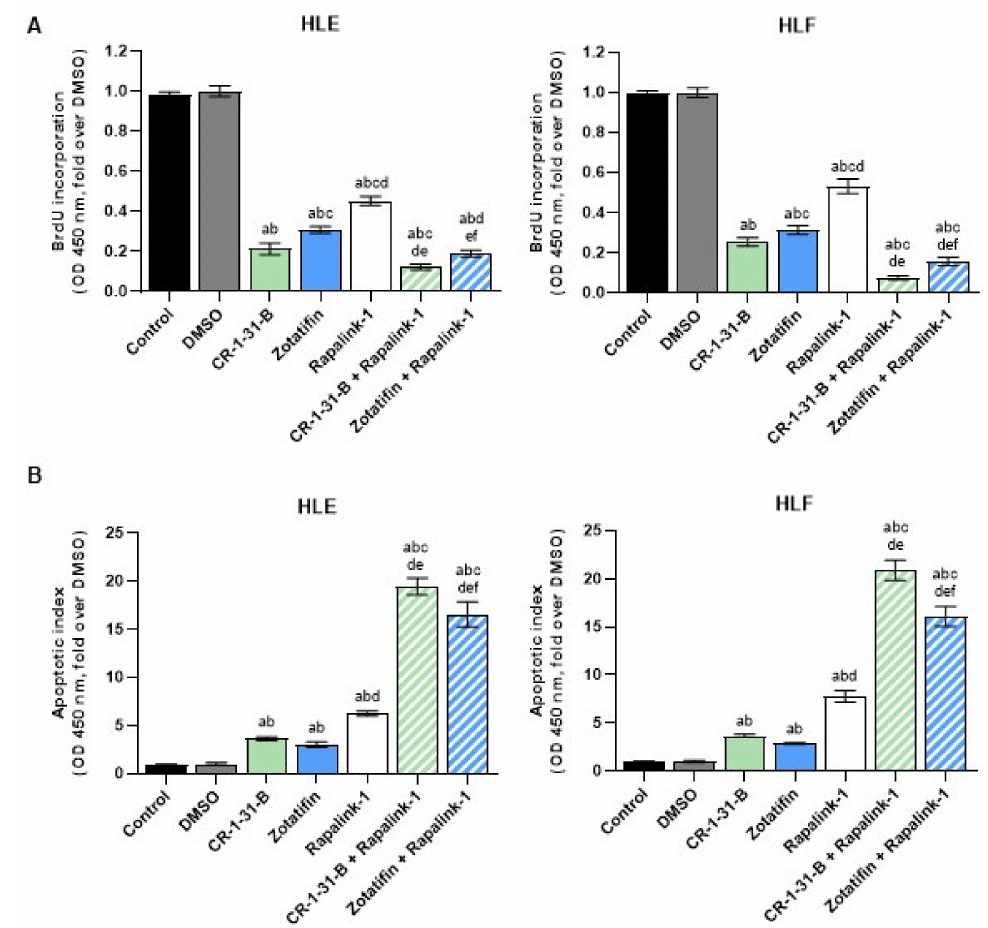
Figure 11. Combining the pan mTOR inhibitor, Rapalink-1, with CR-1-31-B and Zotatifin results in synergistic anti-growth activity in hepatocarcinoma cell lines. ( A ) HLE and HLF cells were exposed to the three drugs, alone or in combination, for 48 h and proliferation was assessed. ( B ) HLE and HLF cells were exposed to the three drugs, alone or in combination, for 48 h and apoptosis was determined. For the experiments in ( A , B ), the drugs were administered at their IC50 concentrations. All results are expressed as mean ± SD of three independent experiments in triplicate. For statistical analysis, Tukey’s multiple comparisons test was performed. Lowercase letters are used to denote statistical significance (a–f: p > 0.0001; a, vs. Control; b, vs. DMSO; c, vs. CR-1-31-B, d, vs. Zotatifin;